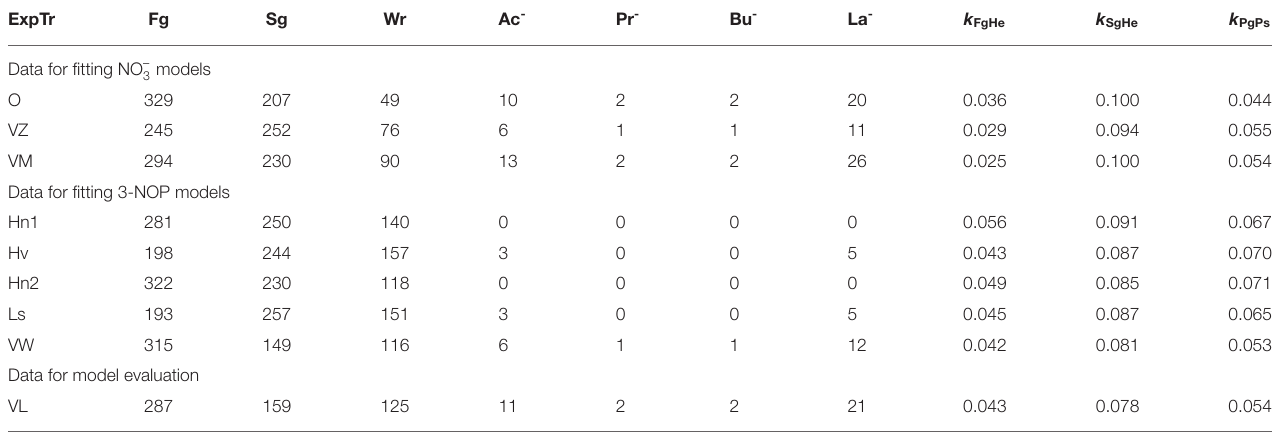
TABLE 4 | Degradable fiber (Fg), degradable starch (Sg), degradable protein (Pg) soluble sugars (Wr), acetate (Ac – ), propionate (Pr – ), butyrate (Bu – ), and lactate (La – ) feed contents [g · kg − 1 ], and fractional hydrolysis rates [h − 1 ] of degradable fiber and degradable starch per experiment and/or treatment assigned (ExpTr) for 3-NOP and NO – 3 model fitting data from Olijhoek et al. (2016, O), Van Zijderveld et al. (2011, VZ), Veneman et al. (2015, VM), Haisan et al. (2014, Hn1), Hristov et al. (2015, Hv), Haisan et al. (2017, Hn2), Lopes et al. (2016, Ls) and Van Wesemael et al. (2019, VW), and model evaluation data from Van Lingen et al. (2017, VL, average across all treatments and